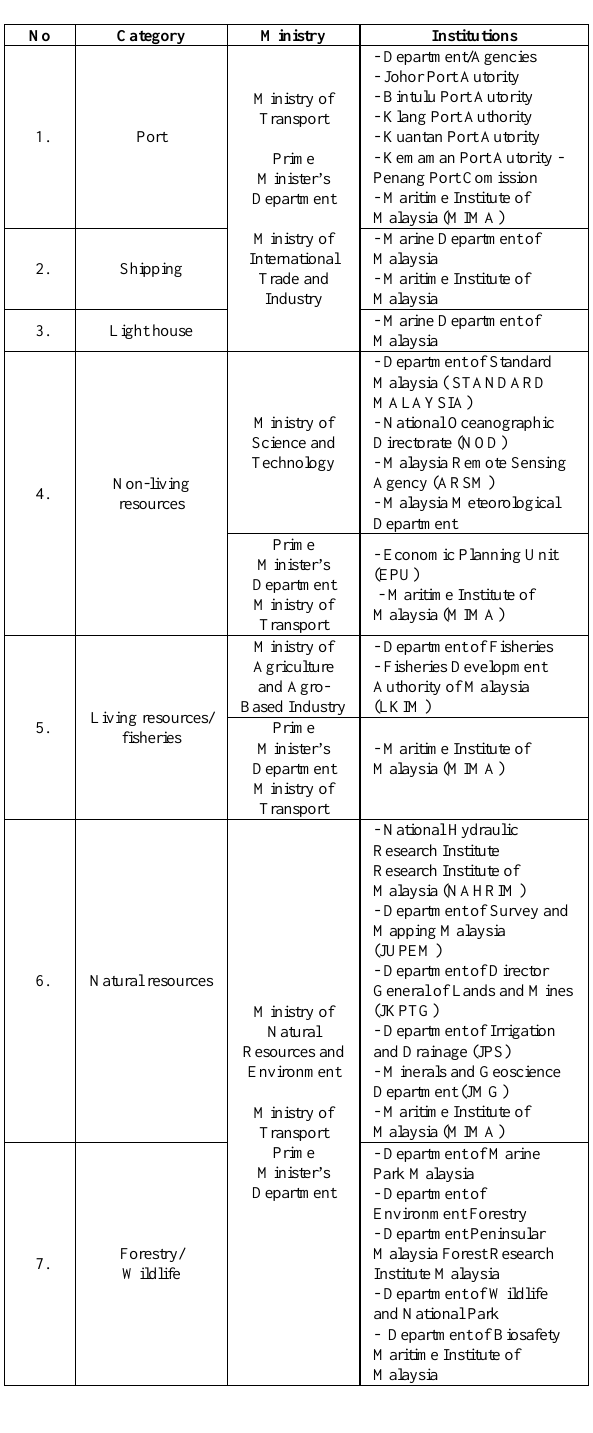
Table 1. List of Marine Related Institutional (Abdullah Hisham Omar et al . ,